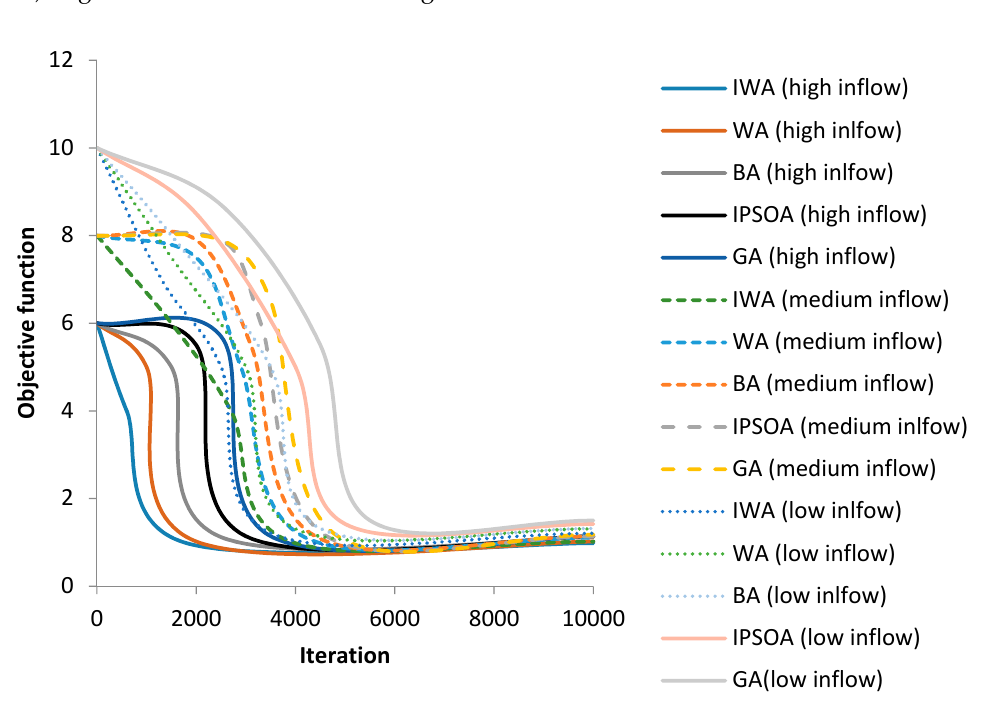
Figure 6. Convergence curve for low inflow, high inflow and medium inflow.